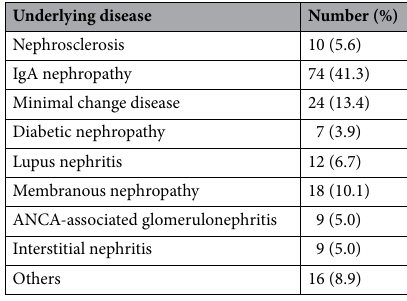
Table 2. Underlying diseases in